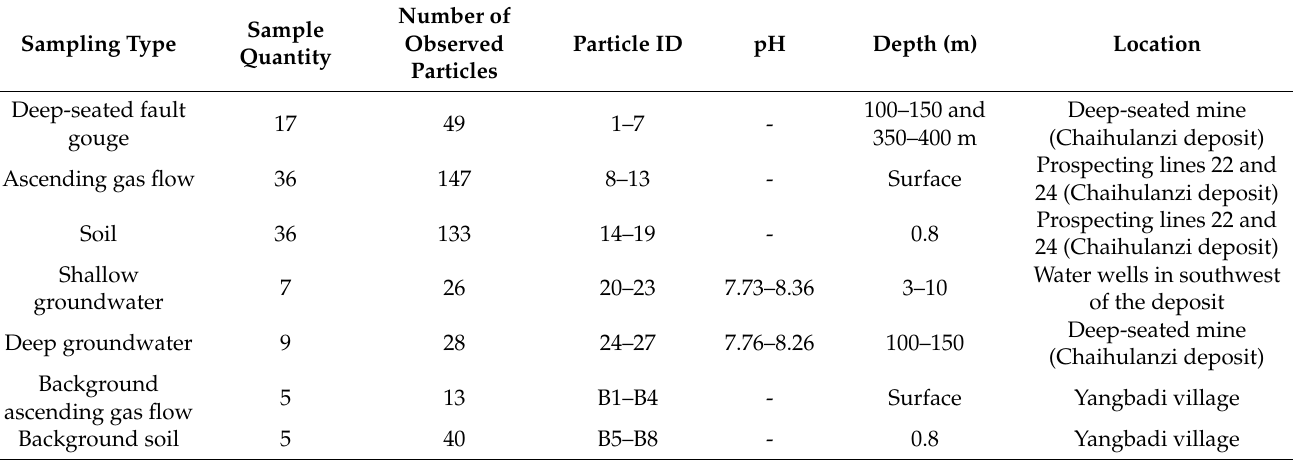
Table 1. The sampling plan and details of